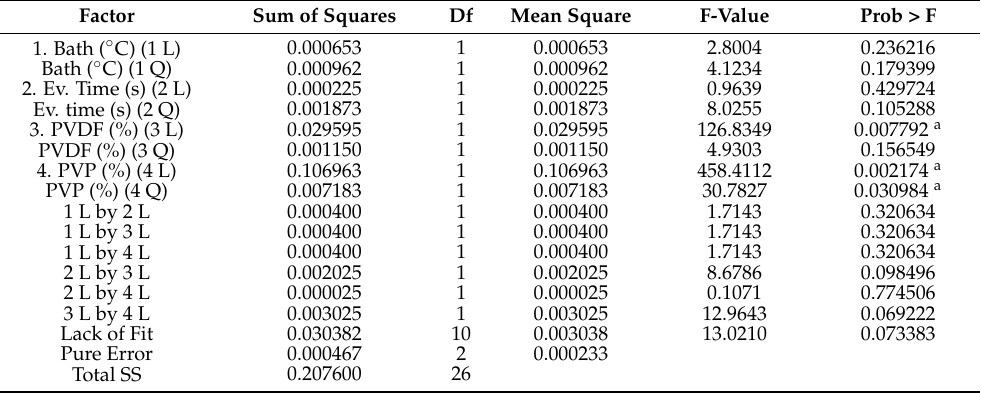
Table 5. Analysis of variance of pore size ( µ m). R 2 = 0.8514; Pure error = 0.0002333. (L) is the linear relation, (Q) is the quadratic relation of the factors, and Df is the degrees of freedom of the analysis. Factor Sum of Squares Df Mean